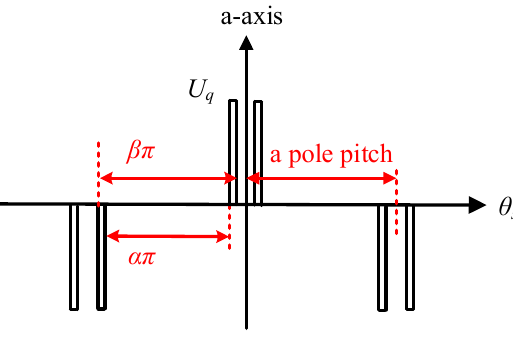
Figure 10. Magnetic potential distribution in the q ‐ axis.